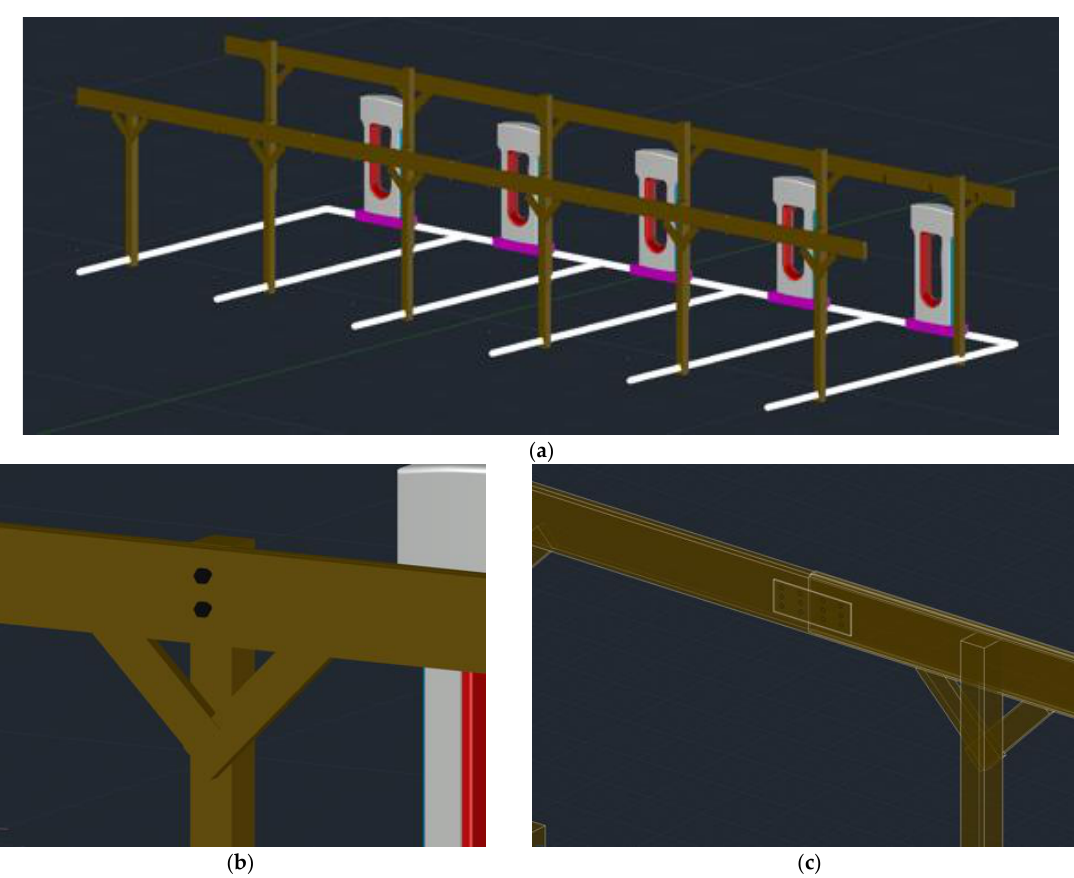
Figure 2. Single Span System ( a ) Double 2 × 12 beams installed across posts, ( b ) 2 3/8″ carriage bolts, and diagonal 2 × 4 braces per connection, and ( c ) 3 × 5 mending plate with 1- 1/2″ joist hanger nails to create splice joint at approximately 20% of the span length.